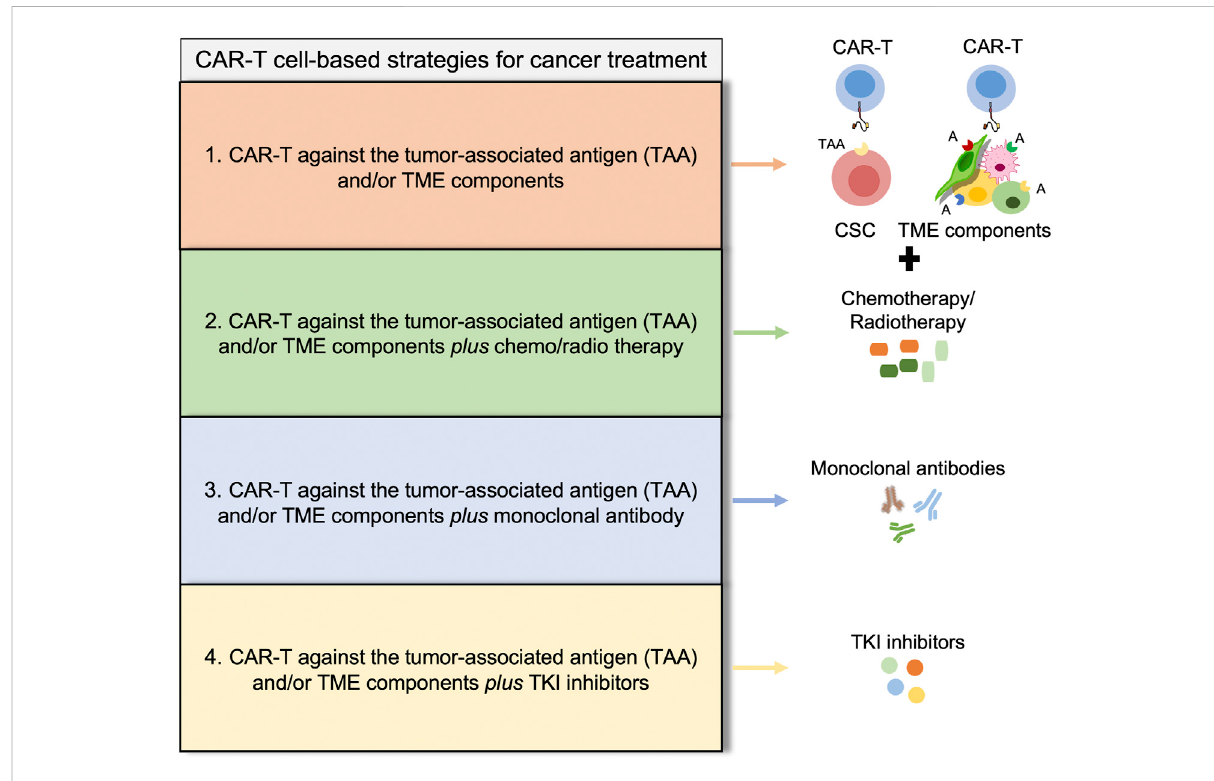
Potential strategies to overcome CAR-T cell-based therapies limitations. Illustrative scheme of different strategies for cancer treatment showing four promising approaches, discussed throughout the manuscript. (1) CAR-T cell based therapies [EpCAM CAR-T (Deng et al., 2015), CD44v6 CAR-T (Casucci et al., 2013; Porcellini et al., 2020), CD166 CAR-T (Wang et al., 2019), c-Met CAR-T (Kang et al., 2021), CD133 CAR-T (Wang et al., 2018)]; (2) CAR-T cell based therapies plus conventional drugs [ROR1 CAR-T plus oxaliplatin (Srivastava et al., 2021), CD133 CAR-T plu s cisplatin(HanY.etal.,2021)];(3)CAR-Tcellbasedtherapiesplusmonoclonalantibody[CD19CAR-Tplustislelizumab(Wangetal.,2021),CD19CAR- Tplusavelumaboratezolizumab(Yamaguchietal.,2022)];and(4)CAR-TcellbasedtherapiesplusTKIinhibitors[PI3Kinhibitor(Funketal.,2022)].All these alternative approaches are developed to improve the persistence of CAR-T cells and the improve immune